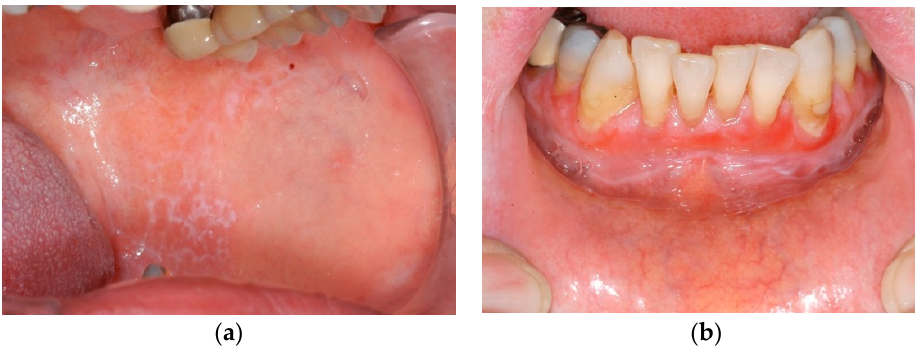
Figure 1. Clinical patterns of oral lichen planus (OLP): ( a ) reticular and ( b ) erosive-ulcerative.